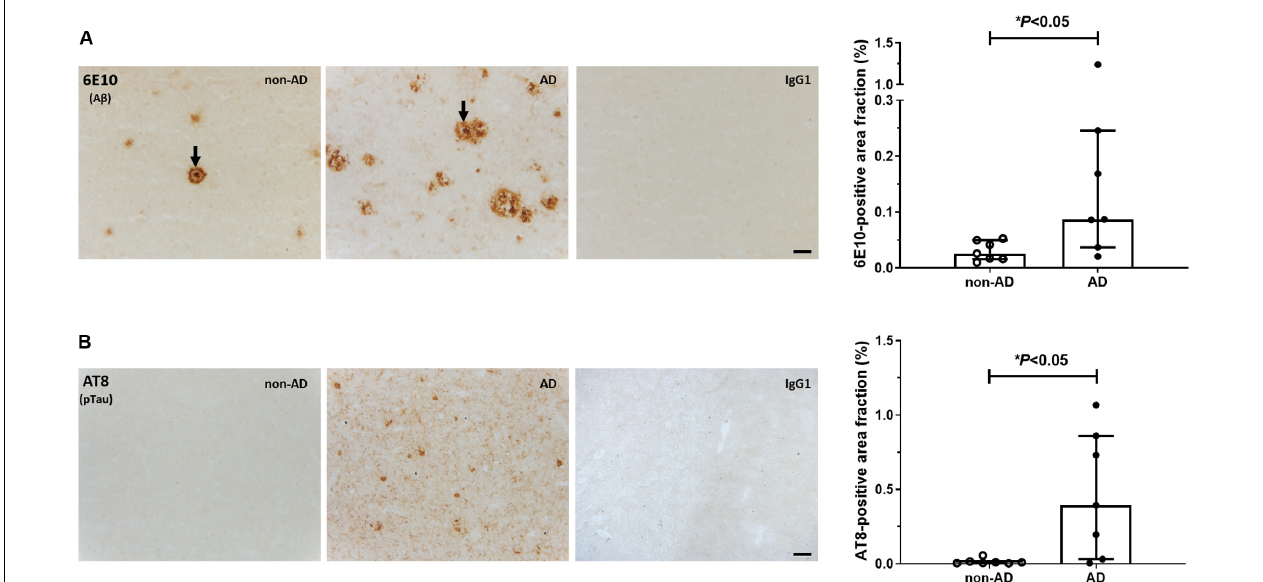
FIGURE 1 | Immunohistochemical analysis of A β and pTau. Representative photomicrographs and quantification of 6E10-positive A β plaques (A) and AT8-positive pTau lesions (B) in the middle frontal gyrus of non-demented subjects and AD patients. Arrows in (A) point to dense-core plaques. No signal was observed in the IgG1 isotype controls. Levels of A β and pTau immunoreactivity were higher in AD vs. non-AD subjects ( ∗ P < 0.05, Mann-Whitney U tests, two-tailed). Results are presented as the median and interquartile range of n = 7 subjects/group. Scale bars: 50 µ